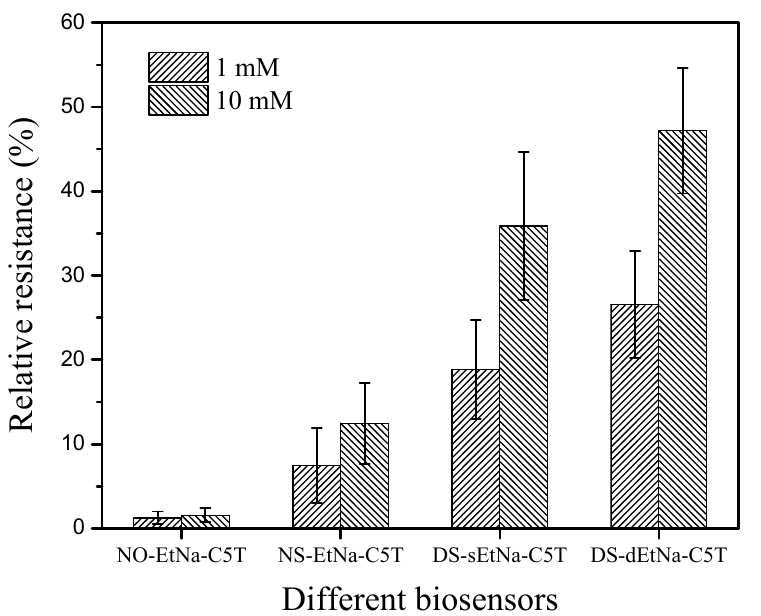
Figure 7. Relative resistances of GCE/SWNT/DNAzymes after incubation in different Ca 2+ concen- trations at various pH values.